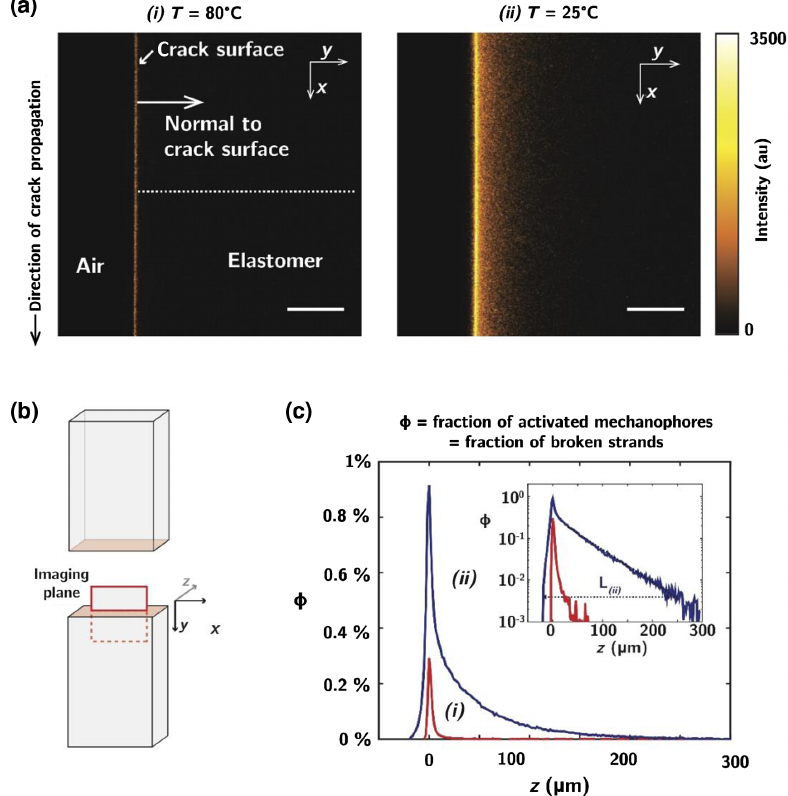
FIG. 3. Postmortem damage quantification through confocal imaging. (a) Postmortem image of fluorescence activation in a poly (methyl acrylate) sample (PMA-DA-0.4, Table I) measured by confocal fluorescence microscopy. Samples are fractured at _ λ ¼ 3 × 10 − 3 s − 1 , respectively, in conditions of (i) low and (ii) high viscoelasticity, at (i) T ¼ 80 °C and (ii) T ¼ 25 °C. Pixel size is 1 . 63 μ m. The scale bar is 100 μ m. The direction of crack propagation is along the x direction (vertical). (b) Schematic of the confocal imaging plane (in red), perpendicular to the crack surface (shown in orange). The direction of crack propagation is along the x direction, the stretch direction along y , and sample thickness along z . (c) Average spatial damage profile ϕ for conditions (i) and (ii), with damage ϕ defined as the fraction of broken strands in the material, equal to the fraction of activated mechanophores. The inset shows the profiles in lin-log scale, with L ð characterizing the spatial extension of damage for condition ii Þ